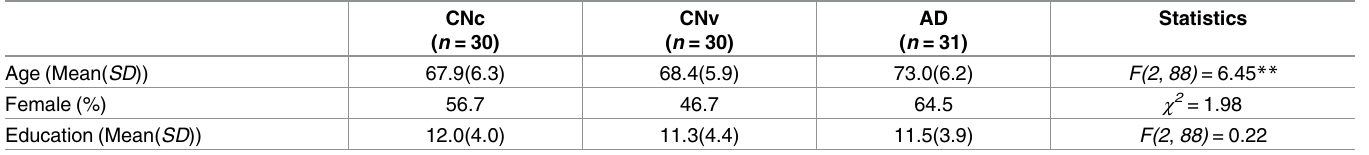
Internal consistency of the selected 50 words was acceptable (Cronbach’s α = 0.77). Test-retest reliability was strong (ICC ρ = 0.79, p < .001). Inter-rater reliability was also strong (Pearson’s r = 0.99, p < .001).